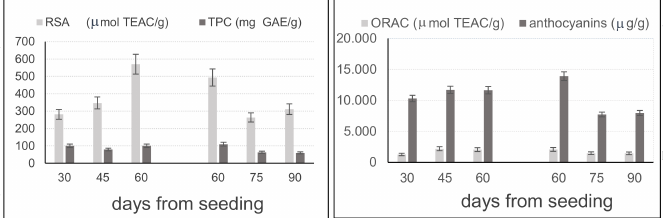
Figure 3. Changes of the measured analytical parameters in ‘Violet Nori’ leaves during the vegetative plant life. Results are expressed on a dry basis.